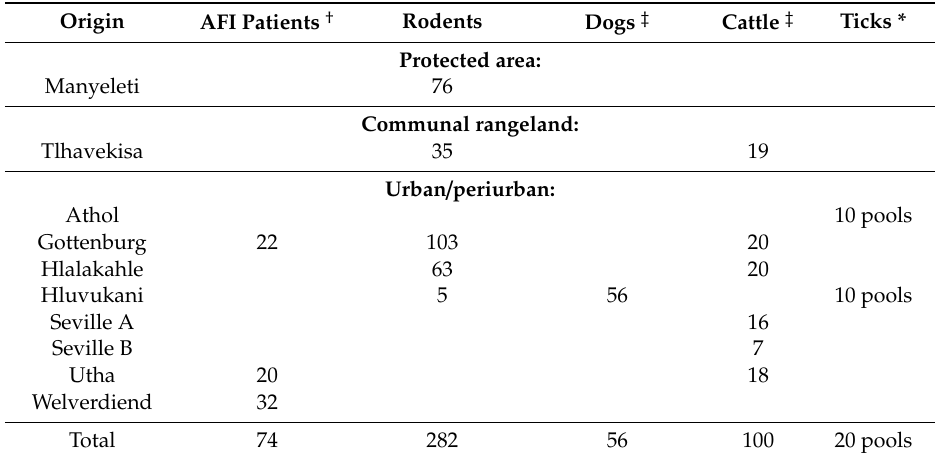
Table 1. Origin and sample sizes of the specimens used in the